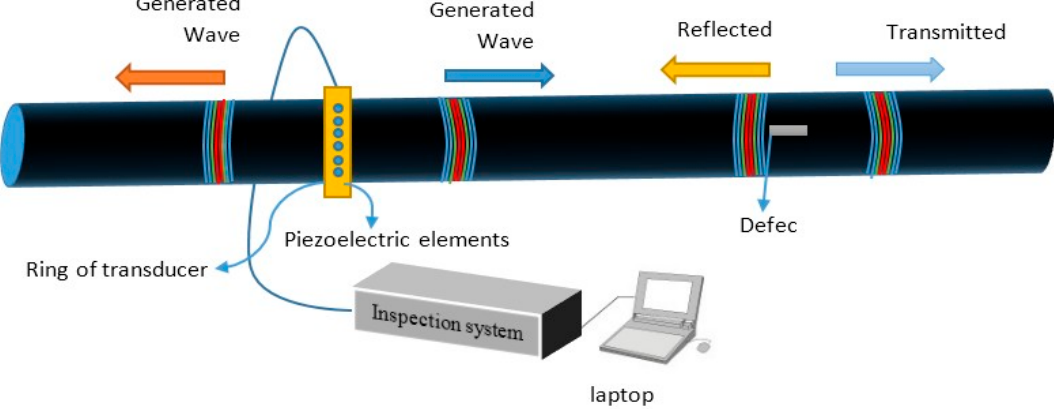
Figure 1. Pipe inspection system using GW.